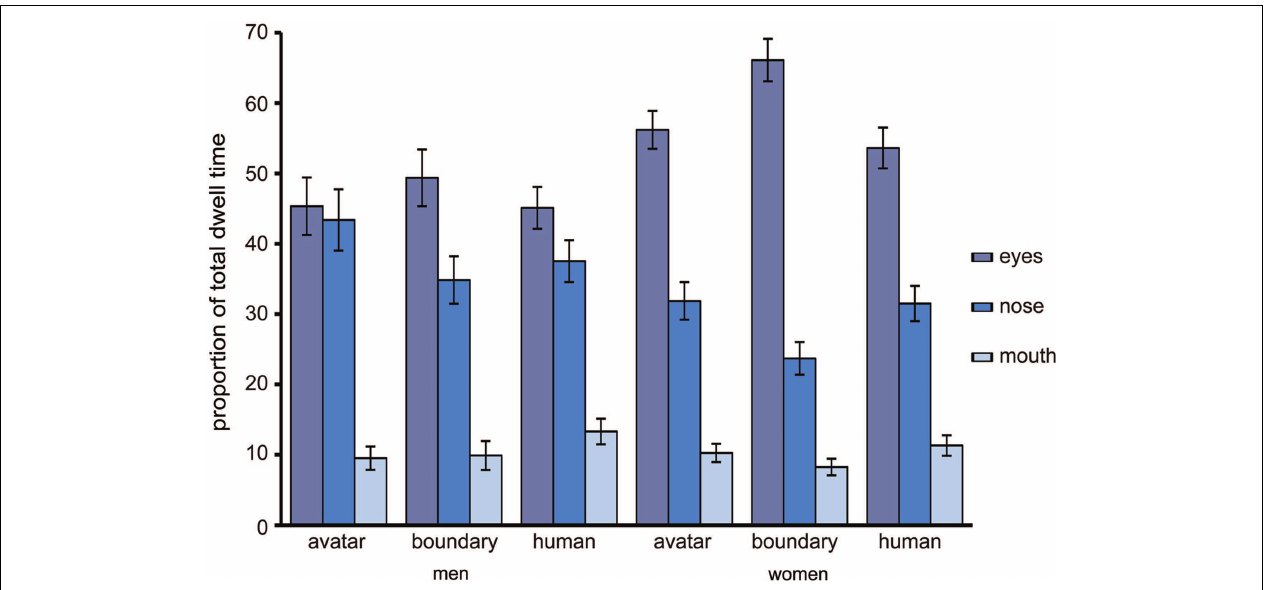
FIGURE 5 |The proportion of total fixation duration on the eyes, nose, and mouth. The relative proportion of total dwell time to the eyes, nose, and mouth for the avatar and human categories and for the peak in uncertainty at the category boundary, with error bars as standard errors ( N = 53).